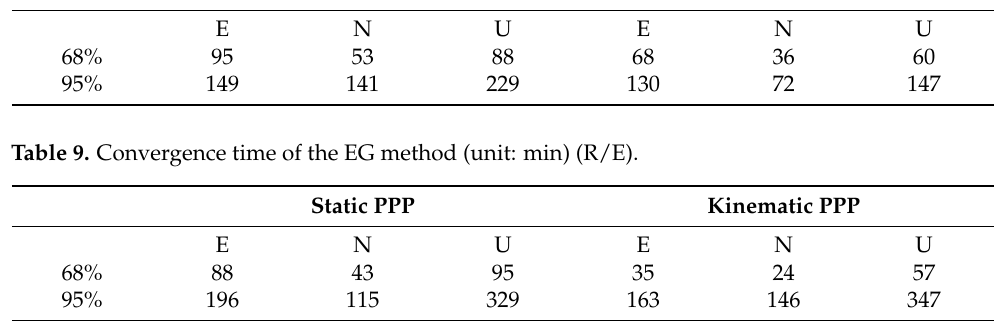
Table 8. Convergence time of the QF method (unit: min) (R/B). Static PPP